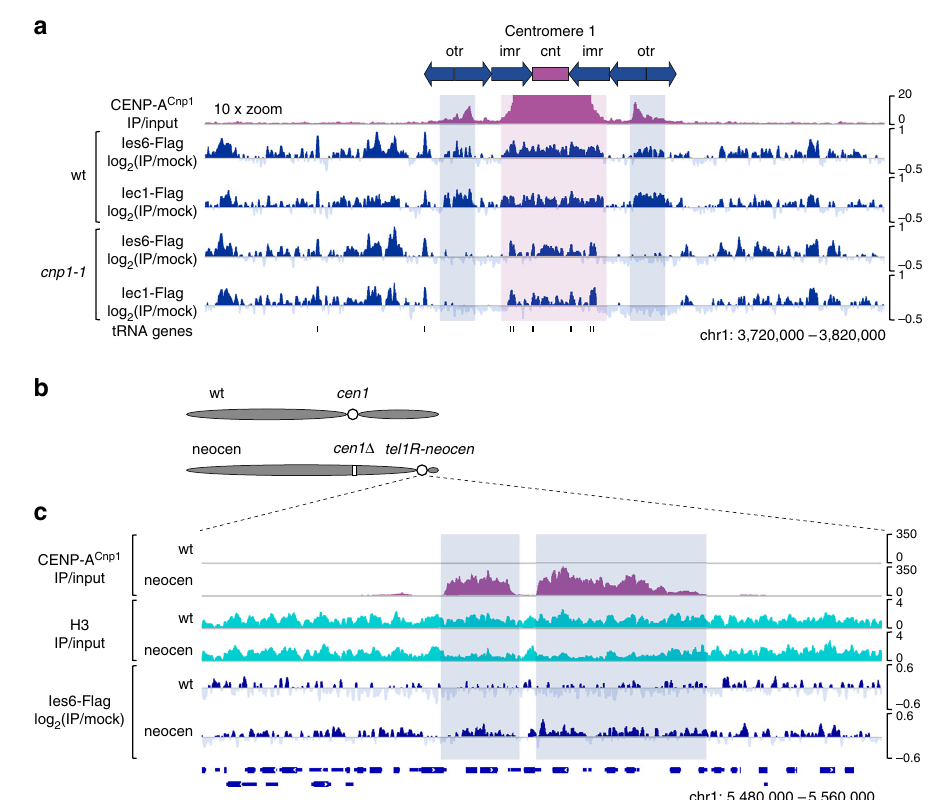
Fig. 3 The Ino80 complex is recruited to centromeres through CENP-A Cnp1 chromatin. a Magni fi ed (×10) views of CENP-A Cnp1 in wt cells and ChIP-Seq pro fi les of Ies6-5×Flag and Iec1-5×Flag in wt and cnp1-1 cells at centromere 1. For Flag ChIP-Seq, wt and cnp1-1 cells were incubated at 36 °C (restrictive temperature for cnp1-1 ) for 3 h after being grown at 25 °C (permissive temperature for cnp1-1 ). The magenta and blue vertical shadings indicate the major CENP-A Cnp1 peaks in the central domain and the minor CENP-A Cnp1 peaks in the heterochromatin, respectively. b A schematic showing the positions of active centromeres ( white circles ) in chromosome 1 of the wt and neocentromere (neocen) strains. The neocentromere strain carries a neocentromere ( tel1R-neocen ) assembled at a subtelomeric region, but lacks the endogenous centromere 1 ( cen1 Δ ; white box ). c Genome browser view of the tel1R-neocen locus showing the ChIP-Seq pro fi les of CENP-A Cnp1 , histone H3, and Ies6-5×Flag in the wt and neocentromere strains. The blue vertical shadings indicate